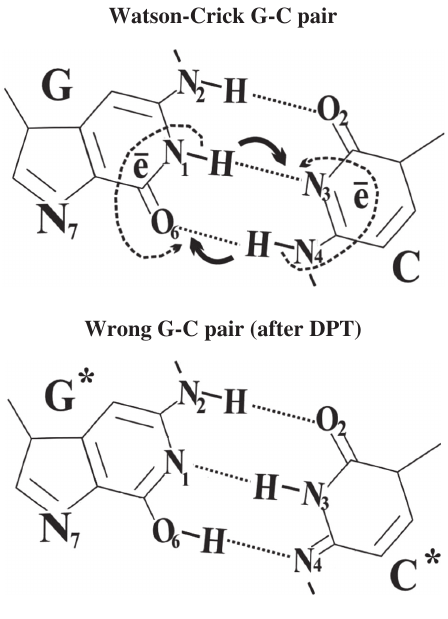
Figure 25 Double proton transfer (DPT) in a G-C part of